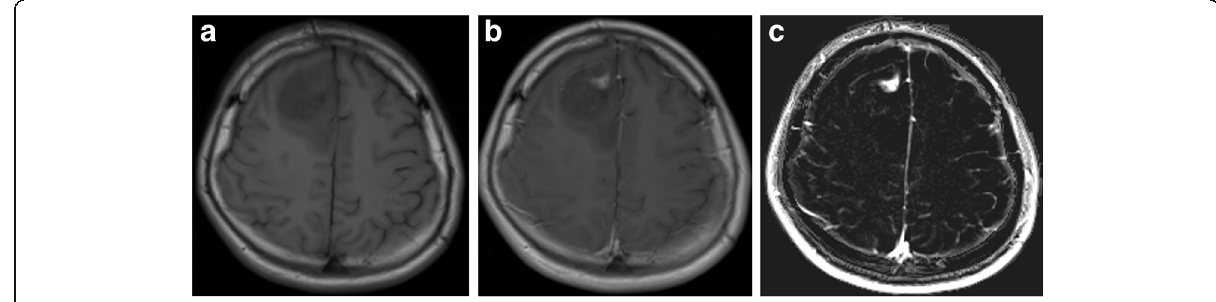
Fig. 2 Paired and harmonised unenhanced ( a ) and contrast-enhanced ( b ) T1-weighted images are utilised to construct the quantitative enhancement (QE) volume ( c ) with enhancement scores from 0.0 (voxel is nonenhancing) to 1.0 (voxel is maximally enhancing). Partially enhancing voxels are ascribed a score between 0.0 and